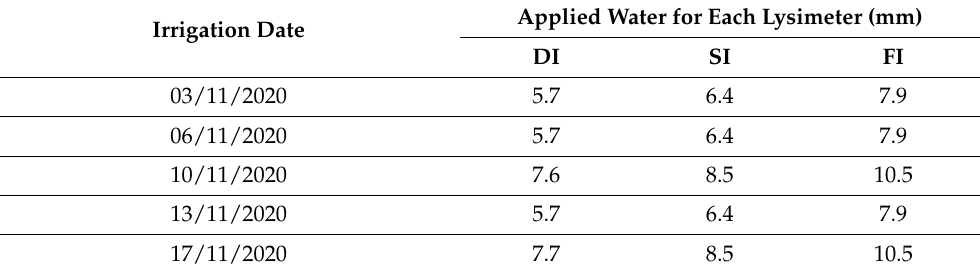
Table 2. Irrigation events and corresponding irrigation water (in mm) under FI, SI, and